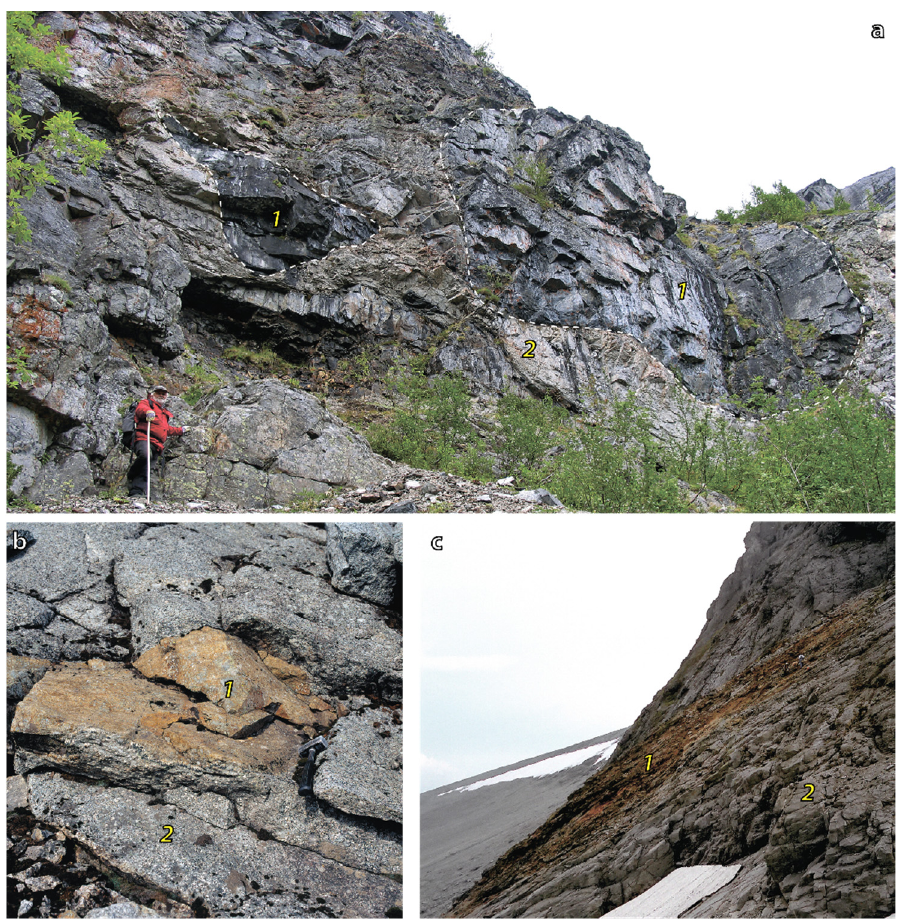
Figure 2. Xenoliths of the aluminous hornfelses (1) among alkaline rocks (2). ( a ) on the Kuivchorr (Lovozero massif); ( b ) on the Yudychvumchorr Mt. (Khibiny massif); the size of this xenolith is 1.5 m × 0.6 m; ( c ) on the Kaskasnyunchorr Mt. (Khibiny massif); the size of this xenolith is 100 m × 50 m. Photos by Gregory Ivanuyk.